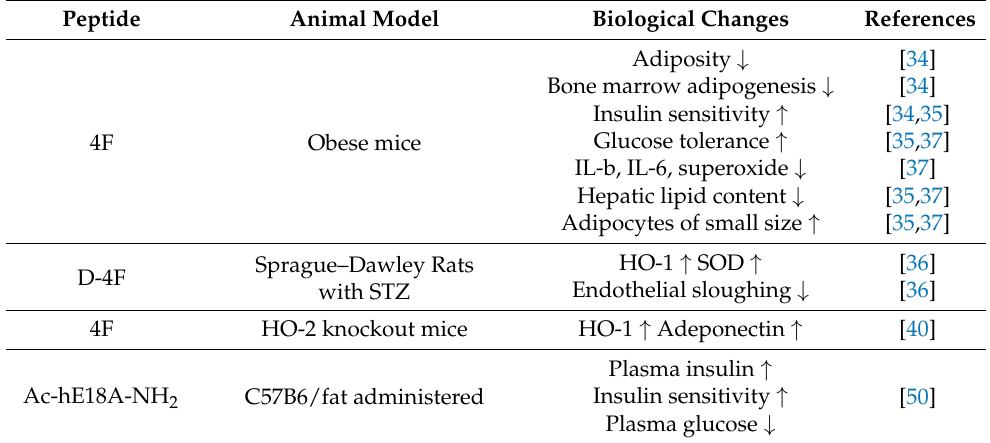
Table 1. Summary of effects of apolipoprotein mimetic peptides in diabetes animal